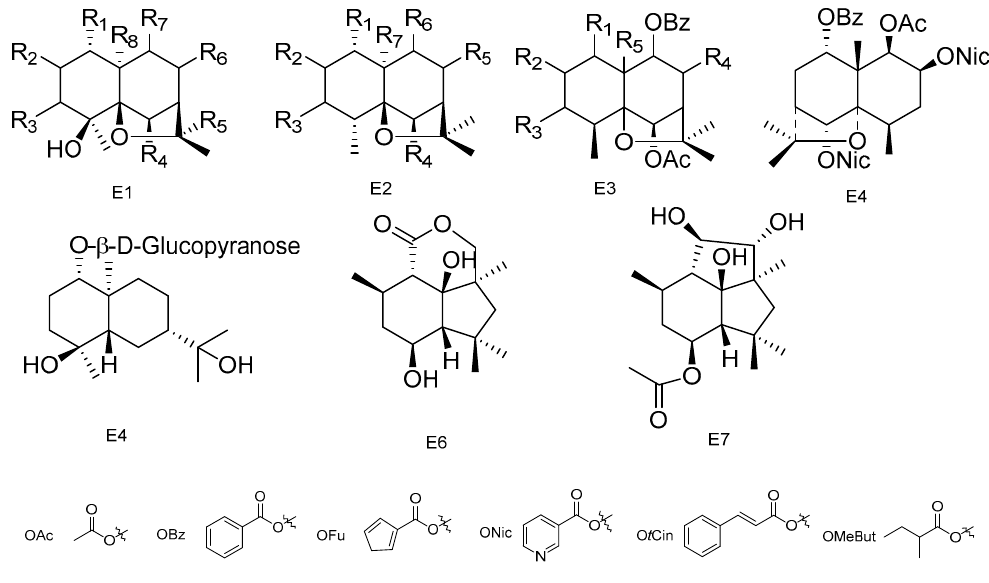
Molecules 2021 , 26 , x FOR PEER REVIEW Figure 5. Seven types (E1–E7) of sesqiterpenoids skeletons. Figure 5. Seven types (E1–E7) of sesqiterpenoids skeletons.